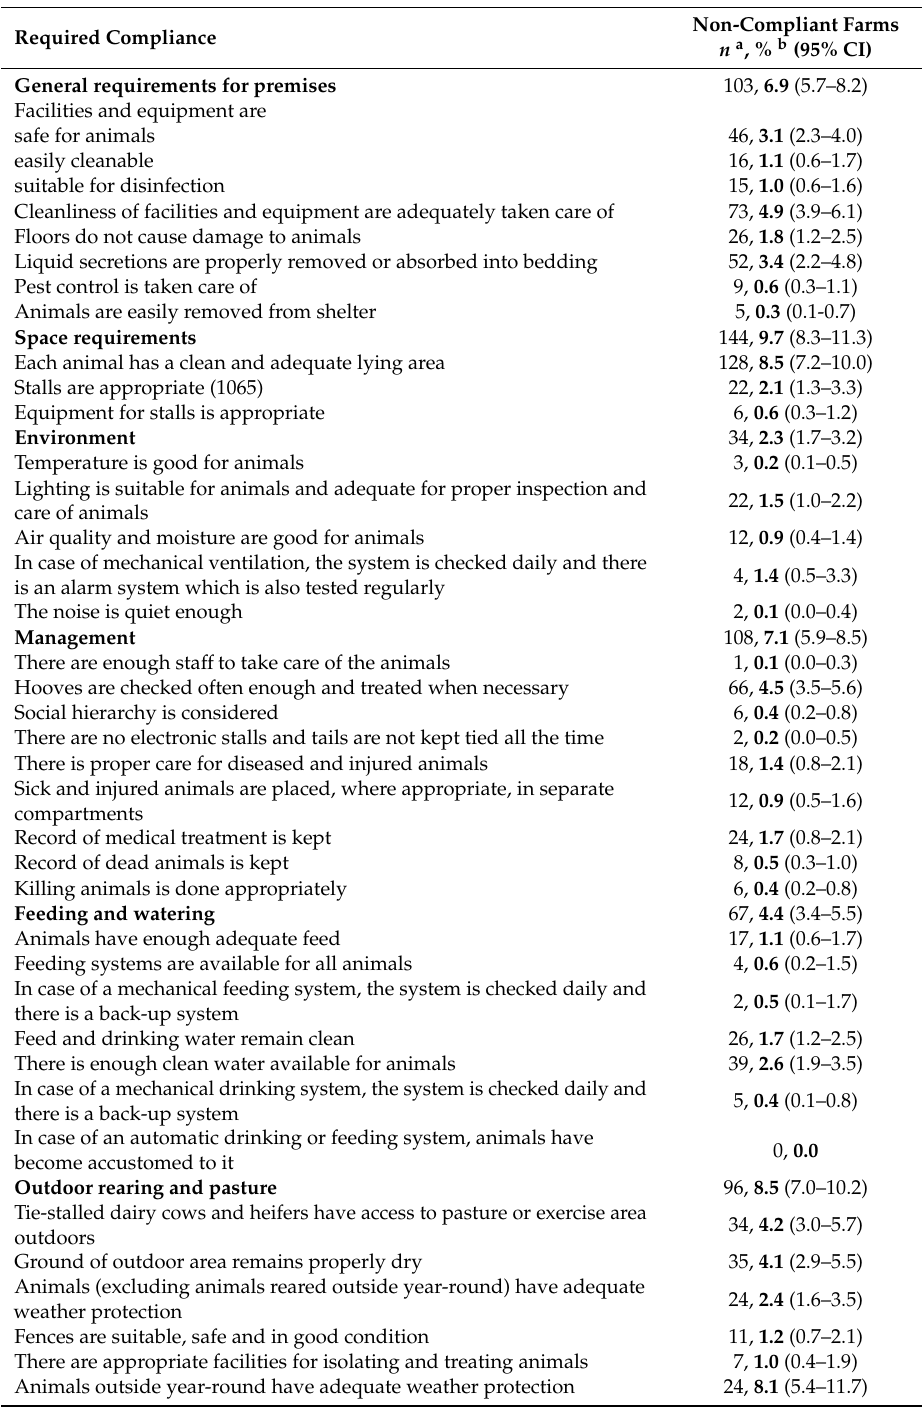
Table 1. Prevalence of cattle farms not complying with the main welfare categories or the checklist requirements concerning adult